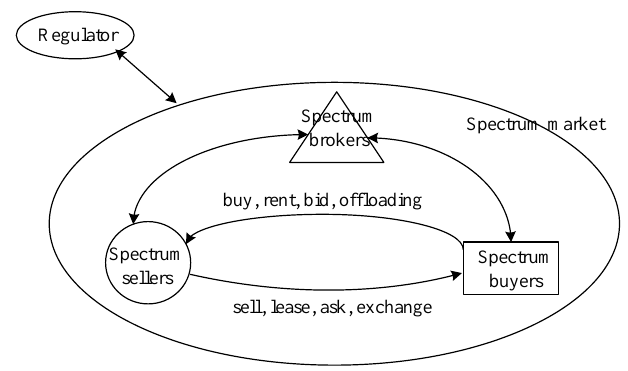
Figure 1. Structure of spectrum trading